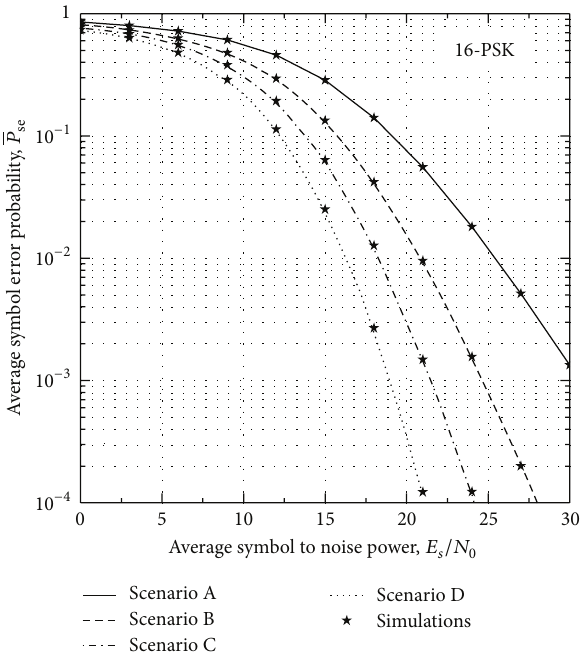
Figure 1: Average symbol error probability, 𝑃 hop DF relaying with RS as a function of the average symbol to noisepower, 𝐸 𝑠 /𝑁 0 ,for 𝐿 = 3 relaysandvariousNakagami- 𝑚 fading conditions.